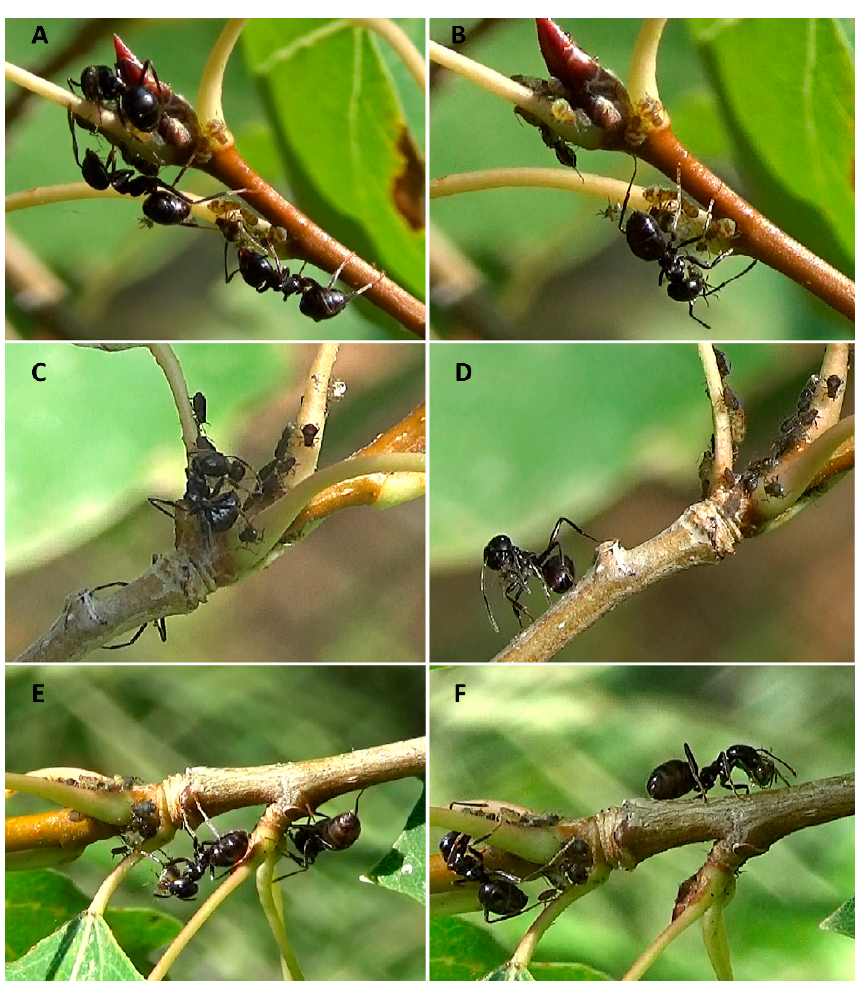
Figure 1. Aphid milkers of Lasius fuliginosus in experimental aphid colonies of Chaitophorus populeti on young aspen trees ( Populus tremula ). ( A ) Antennation of uncontaminated aphid from the control group. ( B – F ) Removal of aphids externally contaminated with conidia: grabbing an aphid ( B , E ), bending abdomen round as if ant were spraying poison to the grabbed aphid ( C ), carrying aphid down the plant ( D , F ).